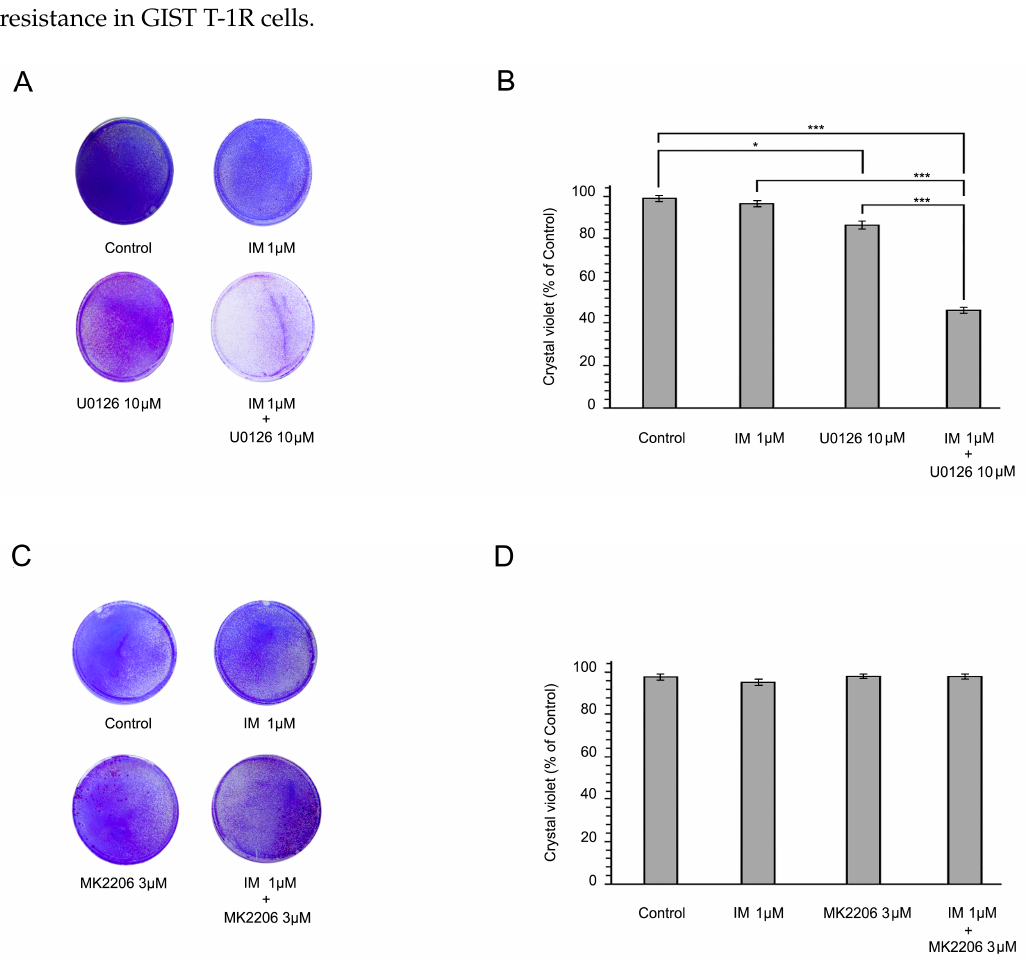
Figure 3. Influence of MEK and AKT inhibition on GIST T-1R resistance to IM. Crystal violet staining of GIST T-1R cells ( A , C ). Cells were treated with DMSO (control), IM (1 µ mol/L), a MEK inhibitor (U0126; 1 µ mol/L) or an AKT inhibitor (MK2206; 1 µ mol/L) alone or in combination for 6 days. The culture dishes were fixed, stained with crystal violet, and photographed. ( B , D ) Quantitative analysis of crystal violet staining of GIST cells treated as described above. The plates were dried, crystal violet was dissolved using 0.1% SDS solution, and absorbance was measured at 590 nm. The graphs represent the mean ± SD. * p < 0.05; *** p <